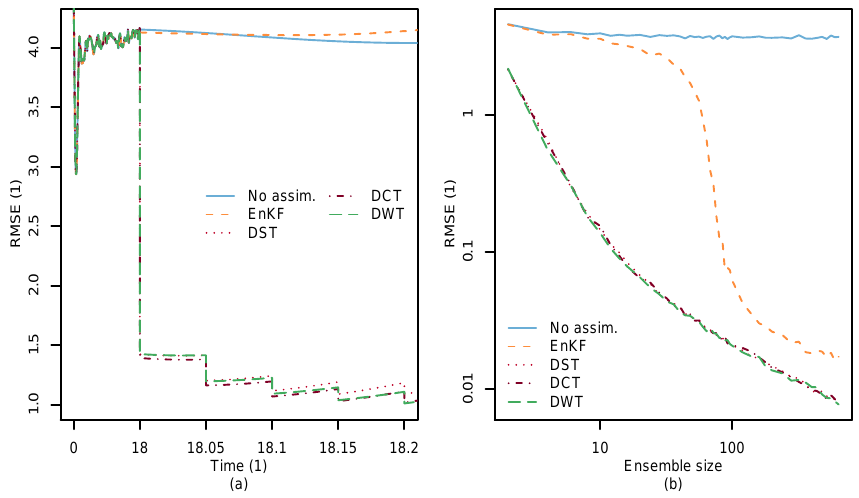
Figure 2. Mean RMSE from 10 realizations for the Lorenz 96 problem, the whole state observed (a) increasing analysis cycles with ensemble size 4, state dimension 256 and (b) increasing ensemble size, analysis cycle 1, state dimension 64.